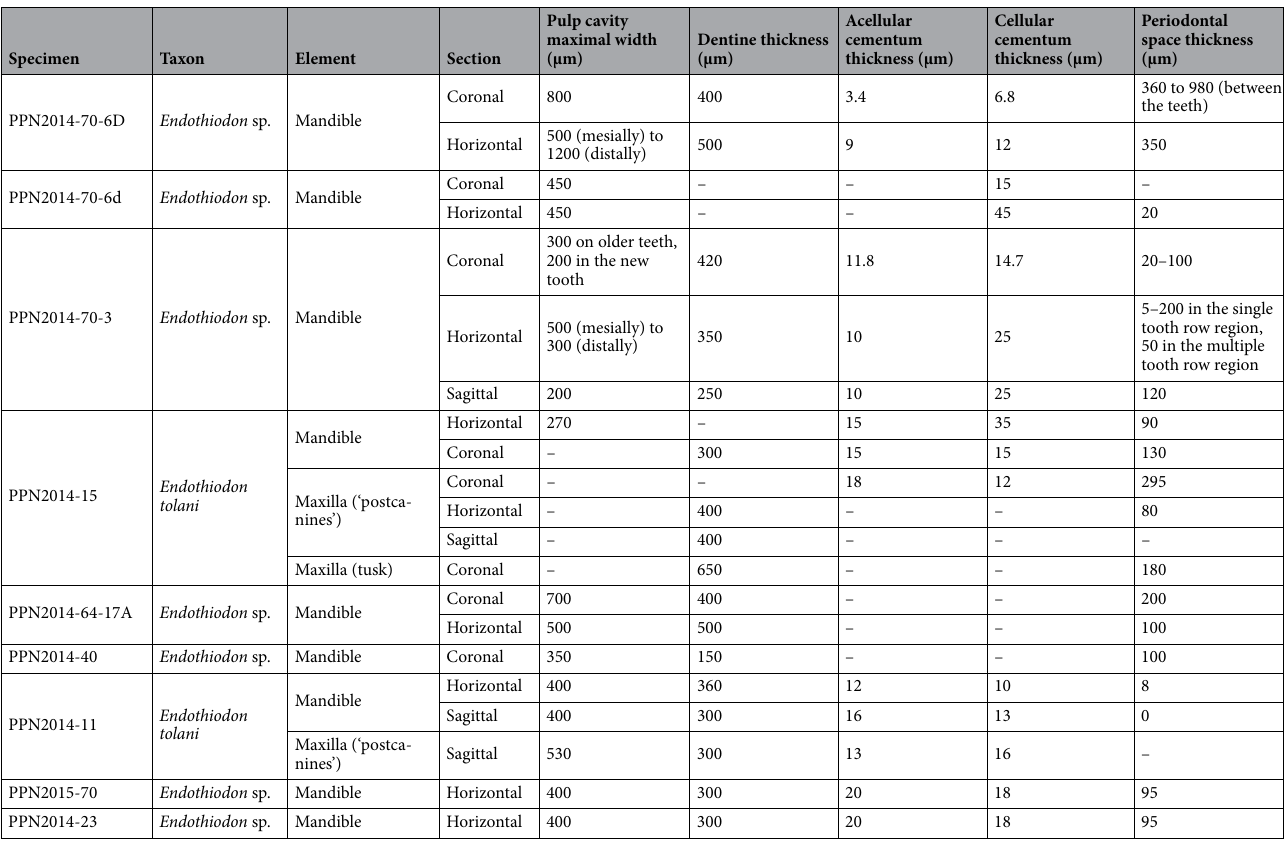
Table 1. Thicknesses of tooth layers seen in histological